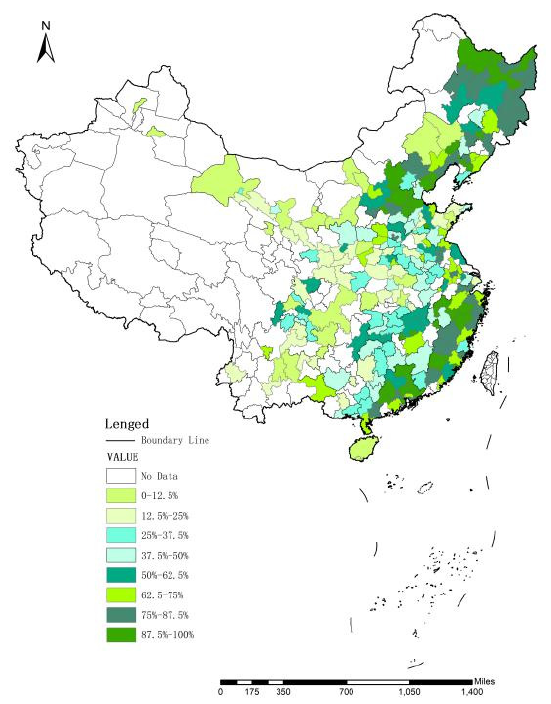
Figure 2. China’s urban ecological footprint in 2014.